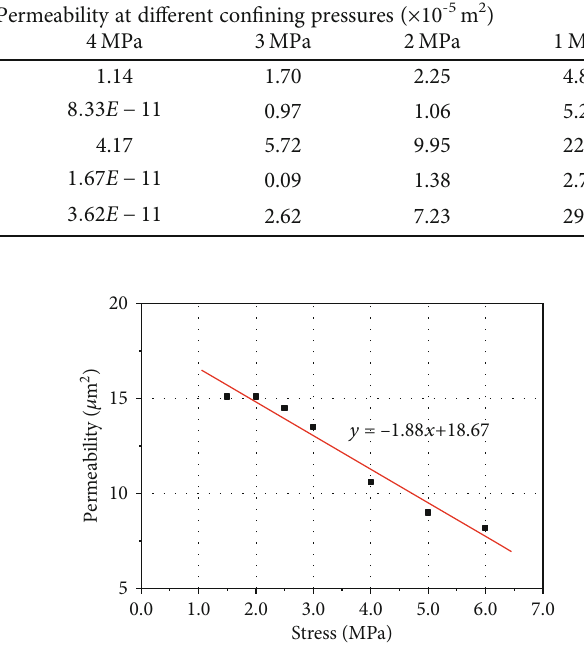
Figure 12: Permeability change curves of rock specimen 3 under loading of con fi ning pressure.